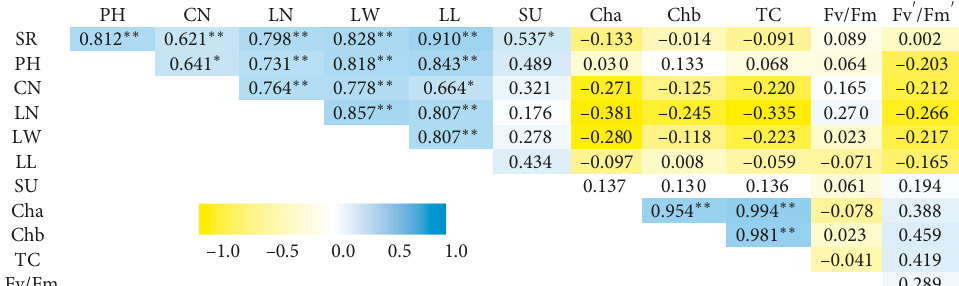
Figure 5: Luem Pua rice phenotypes after salinity treatment for four weeks.